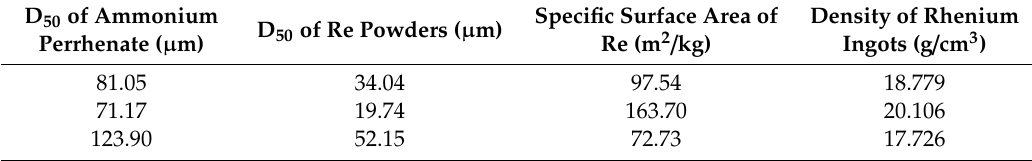
Table 5. The rhenium materials prepared from ammonium perrhenate of di ff erent particle sizes. D 50 of Ammonium Perrhenate ( µ